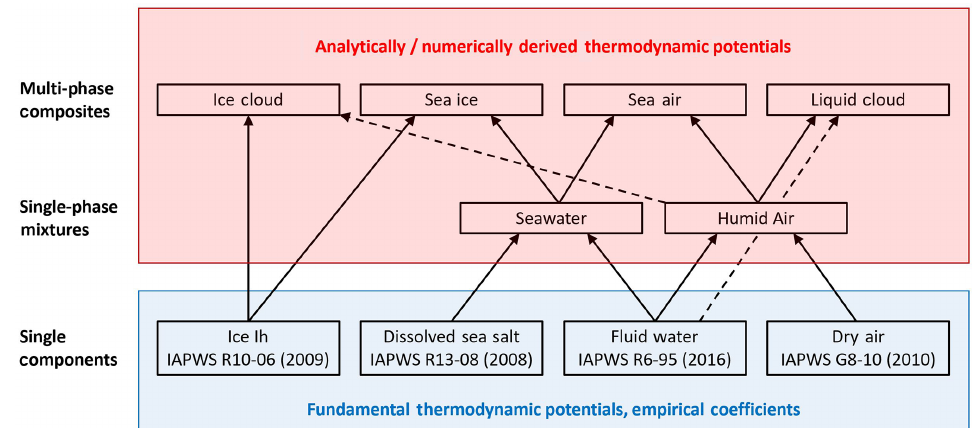
Figure 7. Hierarchical structure of TEOS-10 based on four fundamental thermodynamic potentials defined in IAPWS documents for ice Ih, fluid water, dissolved sea salt and dry air, including air–water interaction properties. Derived from those fundamental equations and their empirical coefficients by numerical and analytical mathematical methods without introducing any additional empirical functions or coefficients, any thermodynamic properties can be computed for the pure substances (such as water and ice), their mixtures (such as seawater and humid air) and multi-phase composites (such as sea ice, ocean–atmosphere equilibria and